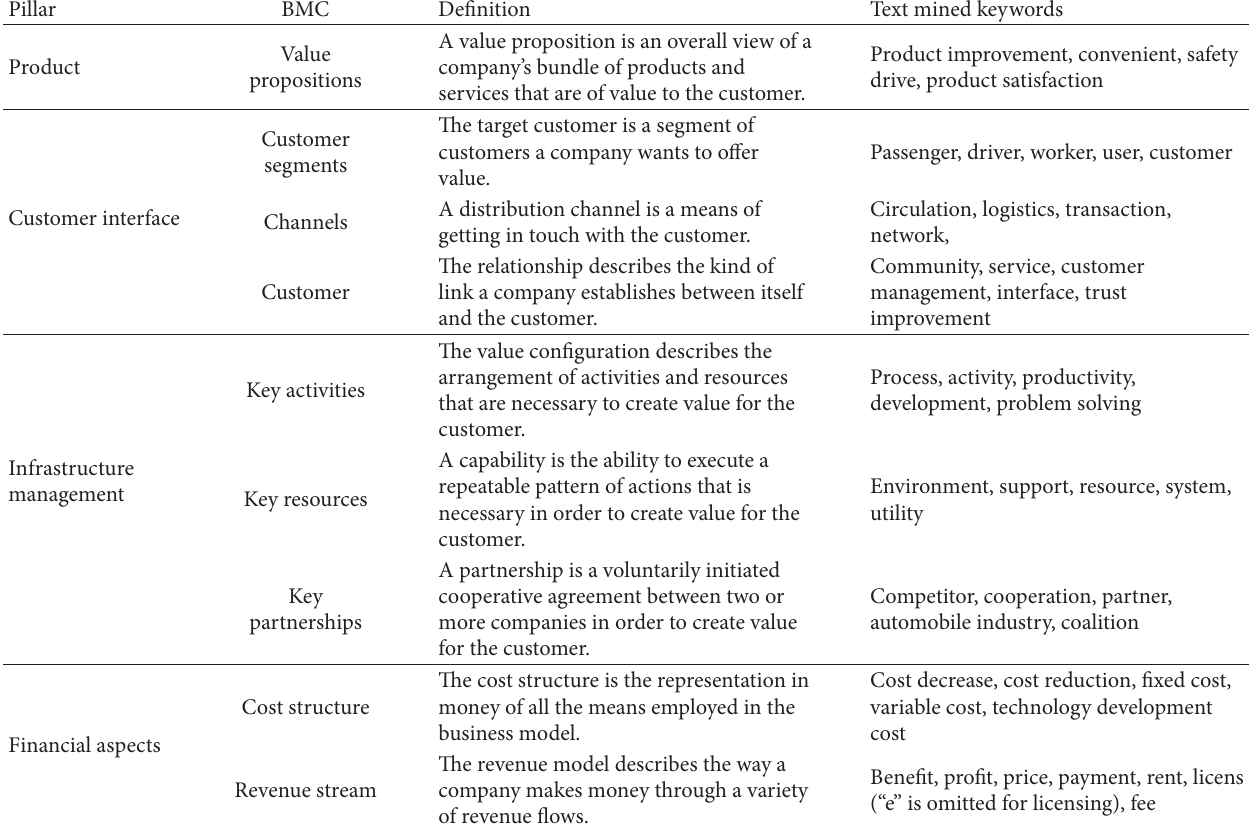
Table 1: BMC definition and Korean automobile industry patents data text mined